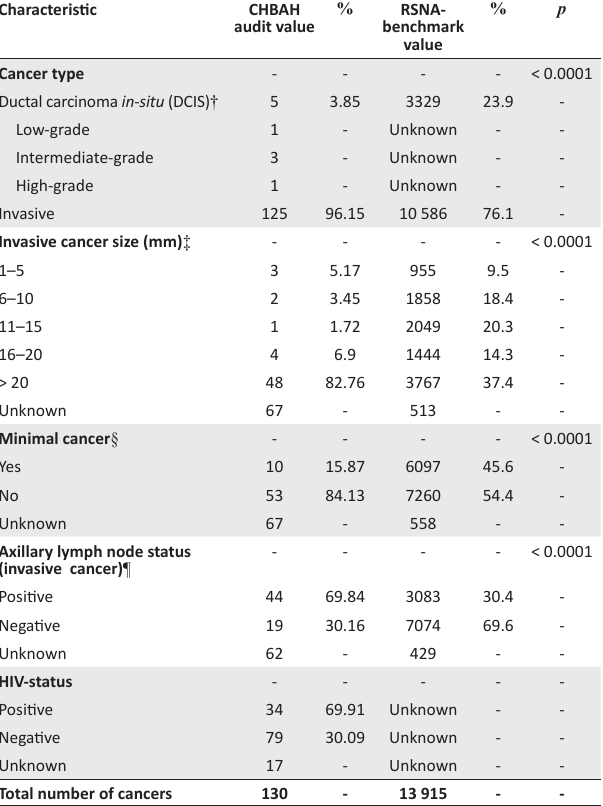
TABLE 7: Derived cancer characteristics for diagnostic mammography ( n = 130).